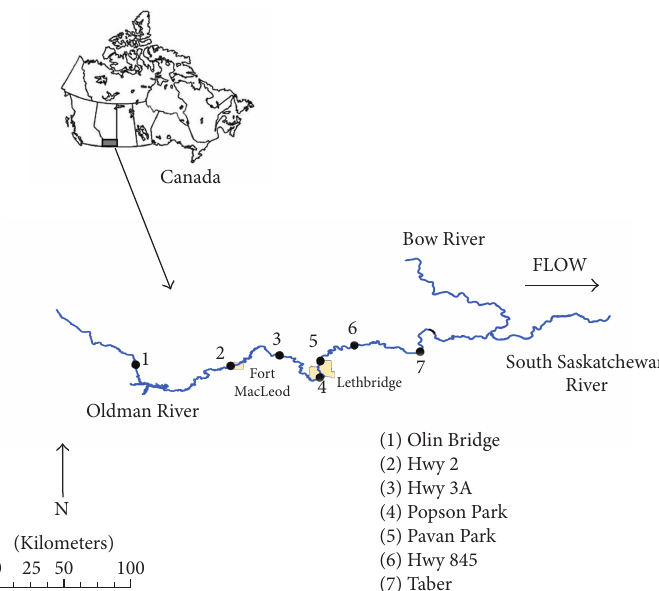
F 1: Map of Canada, the location of the Oldman River basin in southern Alberta and sites sampled (solid dots) for water and longnose dace ( Rhinichthys cataractae) during August and September, 2009. Site names correspond to those used in subsequent �gures.